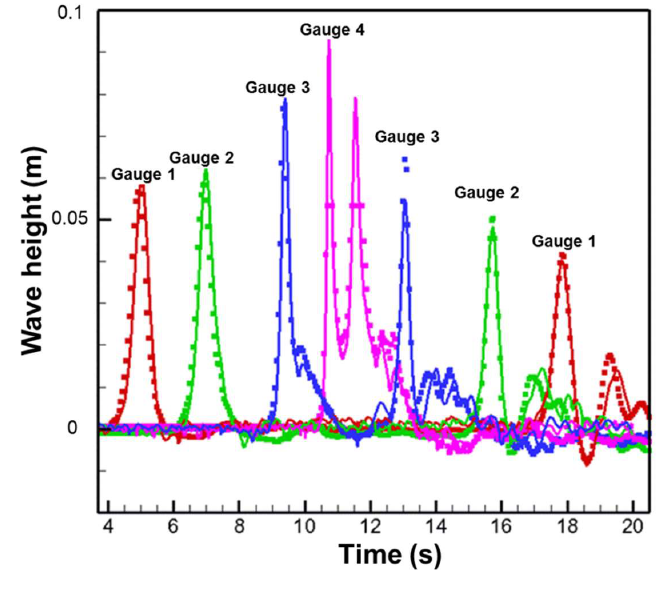
Table 2. Parameters for generating solitary